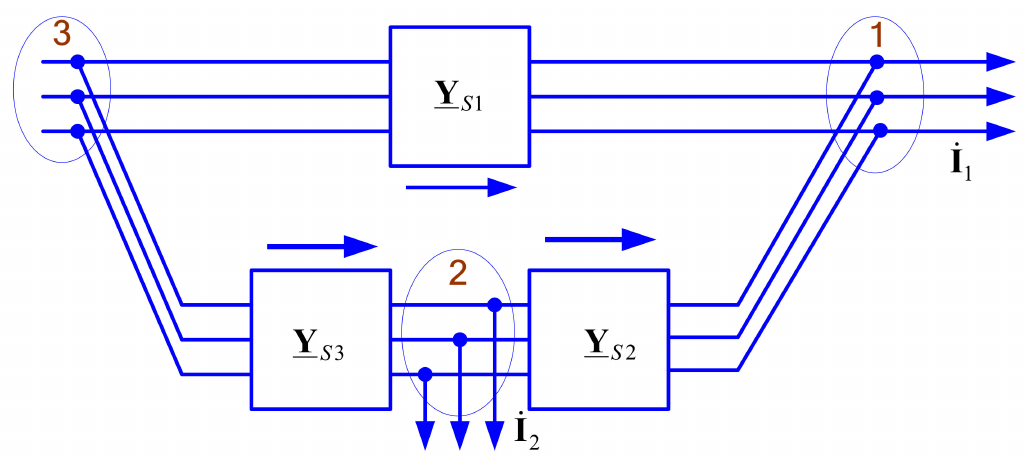
Figure 5. Original circuit of the power transmission line.